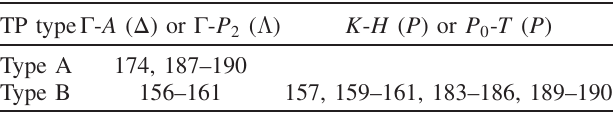
TABLE I. Space groups allowing for TPs of different types with TR symmetry. The points can appear on high-symmetry lines in the Brillouin zone: Γ - A line [ Δ ¼ ð 0 ; 0 ; α Þ ] and K - H line [ P ¼ ð − 1 = 3 ; 2 = 3 ; α Þ ]. Commonly used notations change for the space groups 160 and 161, for which the lines (points) are Γ - P Λ ¼ ð α ; α ; α Þ ] and, in case the lattice constants fulfill ffiffiffi 2 [ p 3 a